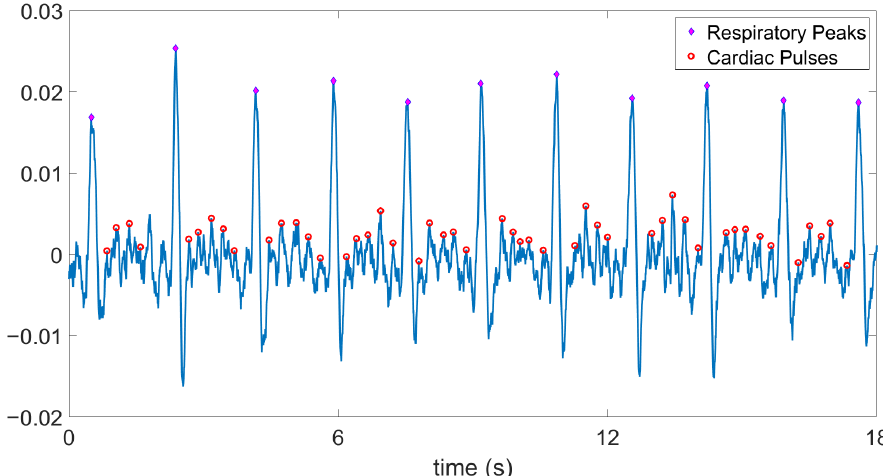
Figure 15. Digital post-processing of the PPG signal from the ASIC output demonstrates discernible heart beats. The mean SD of the averaged heart rate values in between each pair of respiratory ± events is 241 18 bpm and that of respiration rate is 35 1.45 breaths per minute. ± ±